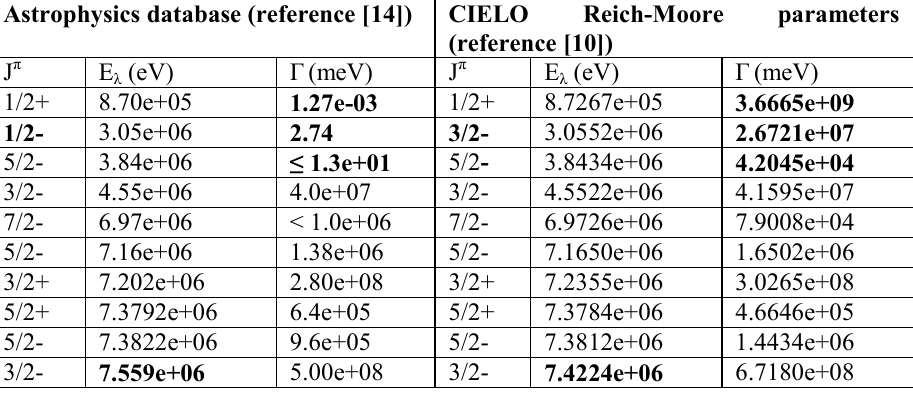
Table 1. The comparison between resonances parameters for ten major levels from the Astrophysics and the CIELO project database using the unified framework. The bold numbers highlight most important differences between the two